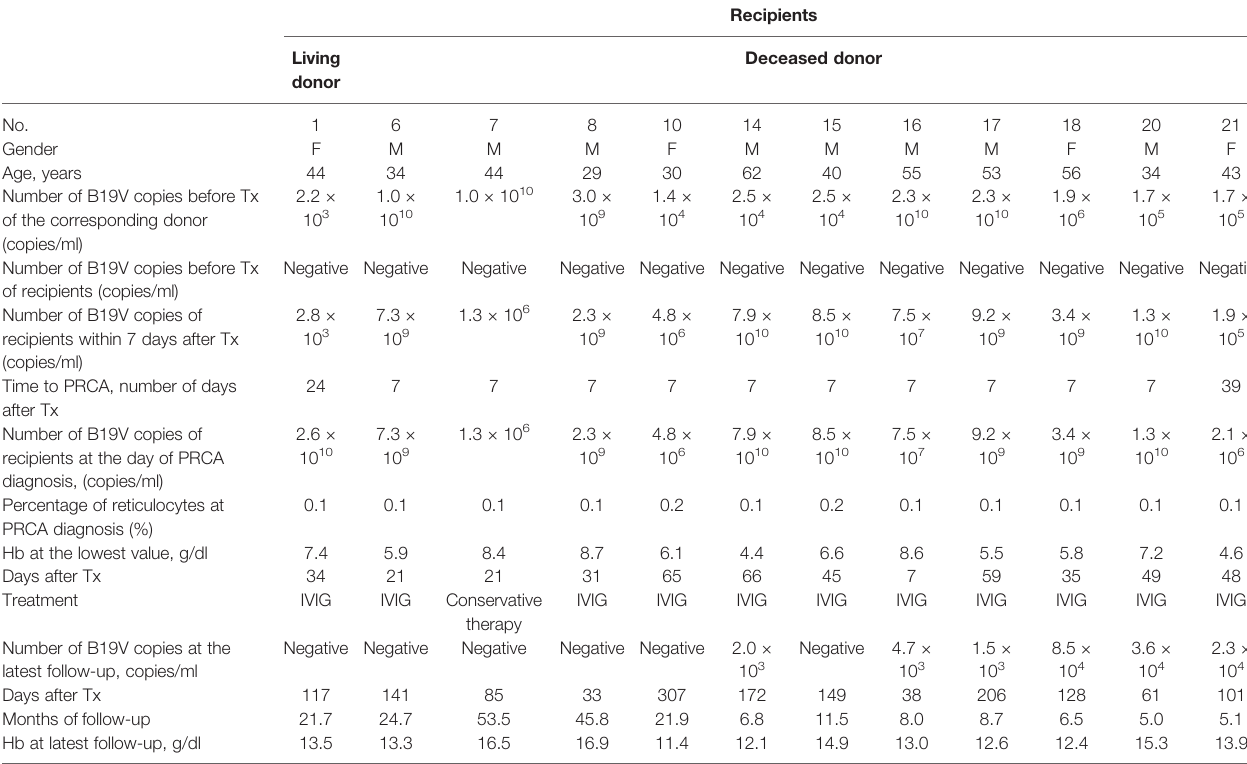
TABLE 2 | Clinical characteristic of recipients with pure red cell aplasia (PRCA) caused by B19V after kidney transplantation.